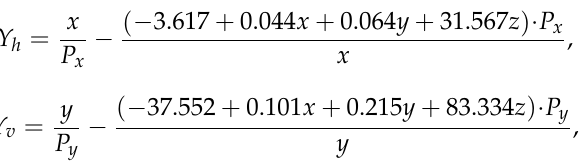
down and gradually becomes gentle in phase Ⅱ in the strain range 25–100% (GF = 0.2673).